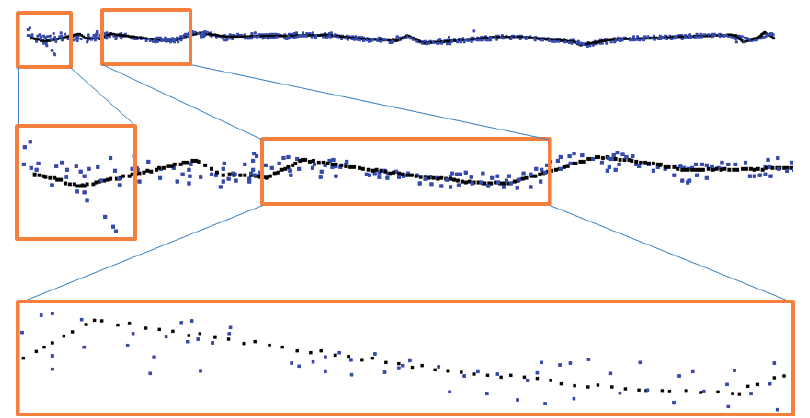
Figure 18. Points representing kE3 roof edge after mixed